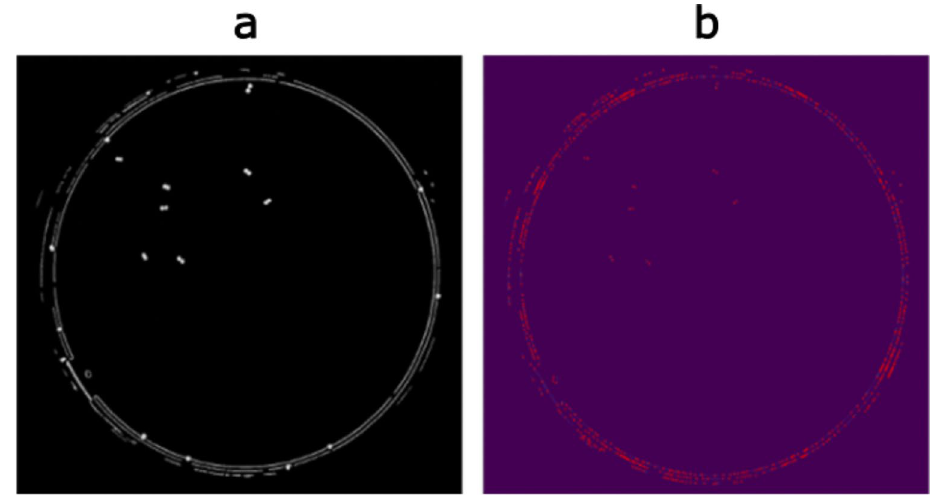
Fig. 2 Overview of local minima detector. a A binarized inverted mask of a grayscale plate image containing only those regions that have been deemed as noise/colony clusters; b The local extrema detected. Note the high amount of noise from the plate borders that will need to be pruned through a comparison with the ground